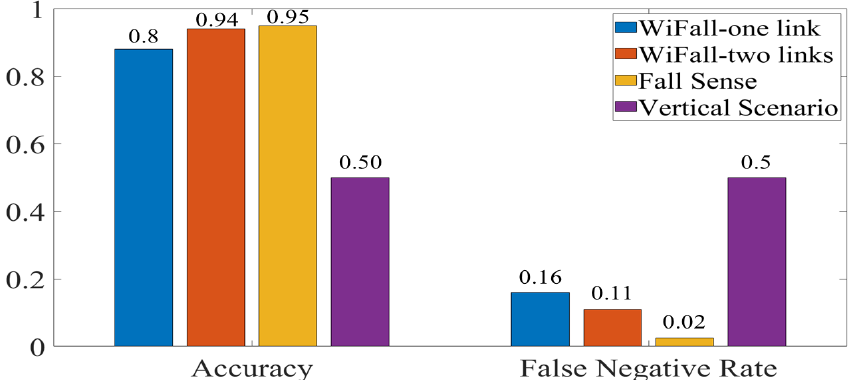
Figure 12. Comparison of Wifall, FallSense and VV